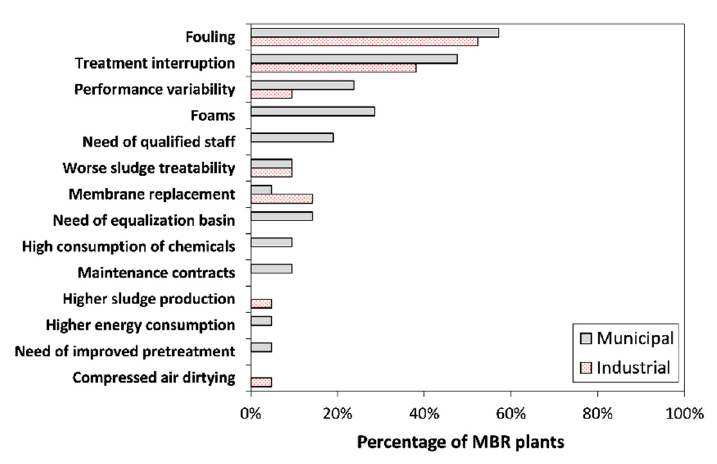
Figure 7. Operational troubles of MBR plants: comparison between municipal and industrial facilities.